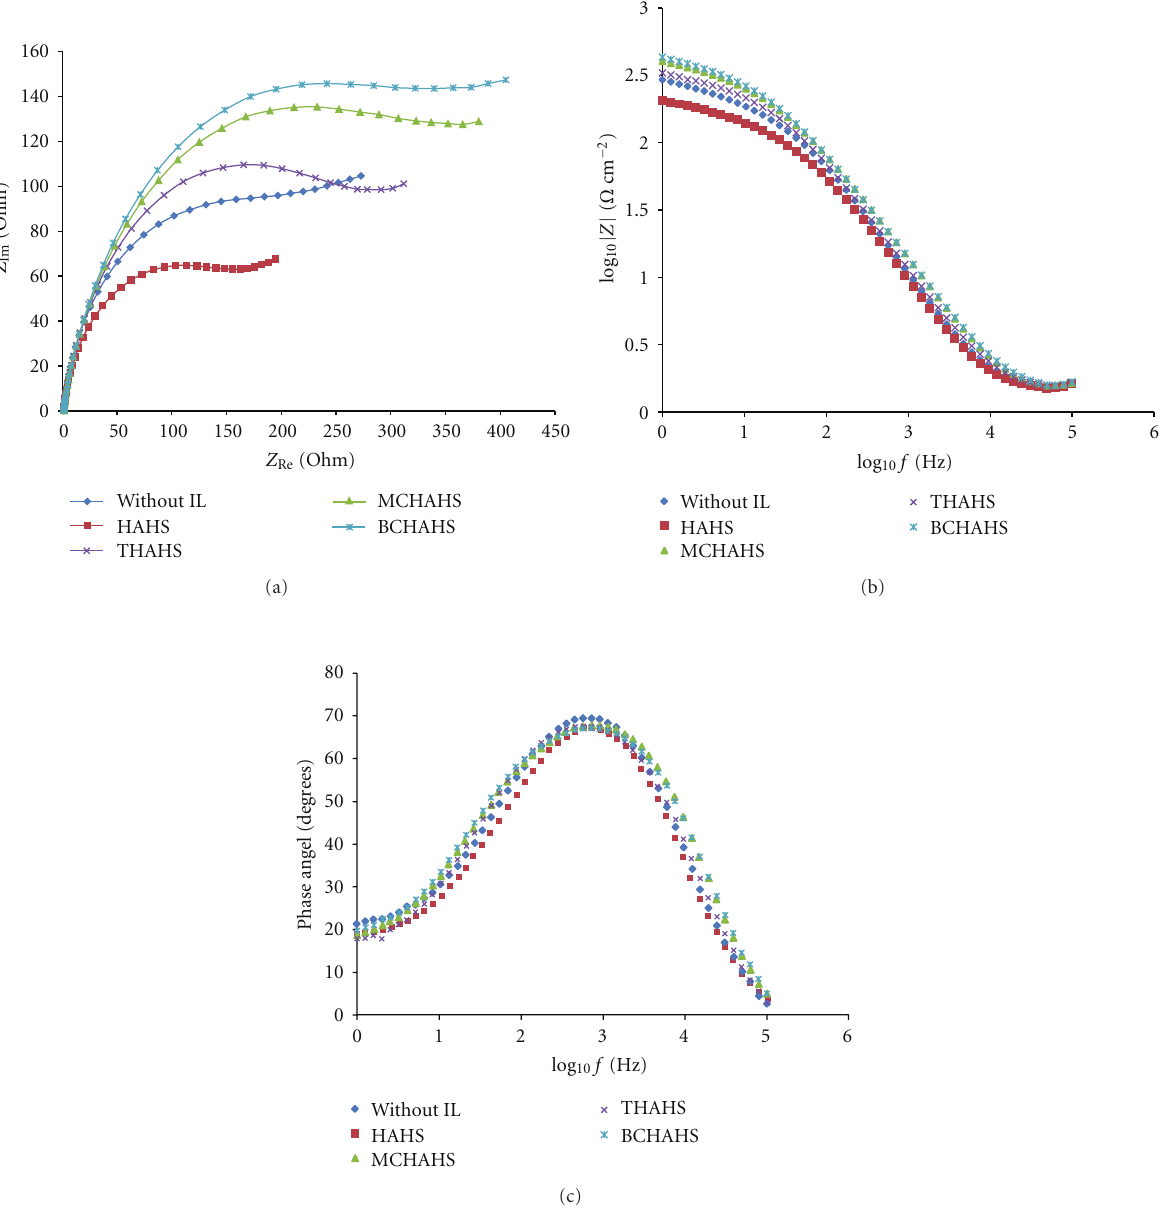
Figure 7: Nyquist (a) and Bode diagrams (b and c) of Pb-Sb-Sn alloy in open circuit potential in 4.0 mol · L − 1 H 2 SO 4 with di ff erent ILs and equal concentration 15 µ g mL − 1 . Conditions: scan rate, 10mVs − 1 ; H 2 SO 4 , 4.0 mol · L − 1 ; immersion time,